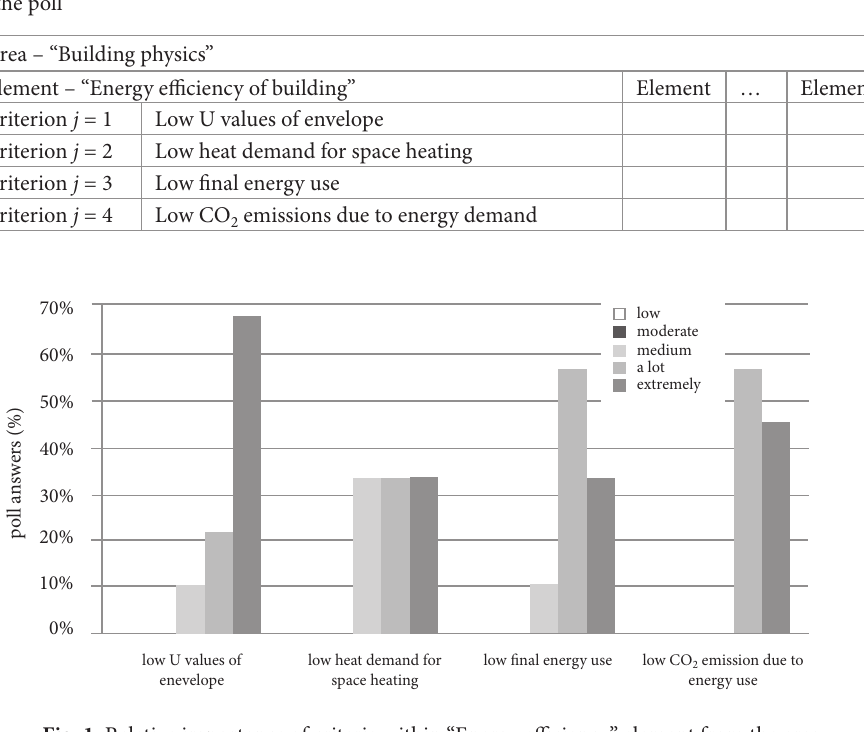
Fig. 1. Relative importance of criteria within “Energy efficiency” element from the area “Building physics” as determined by the